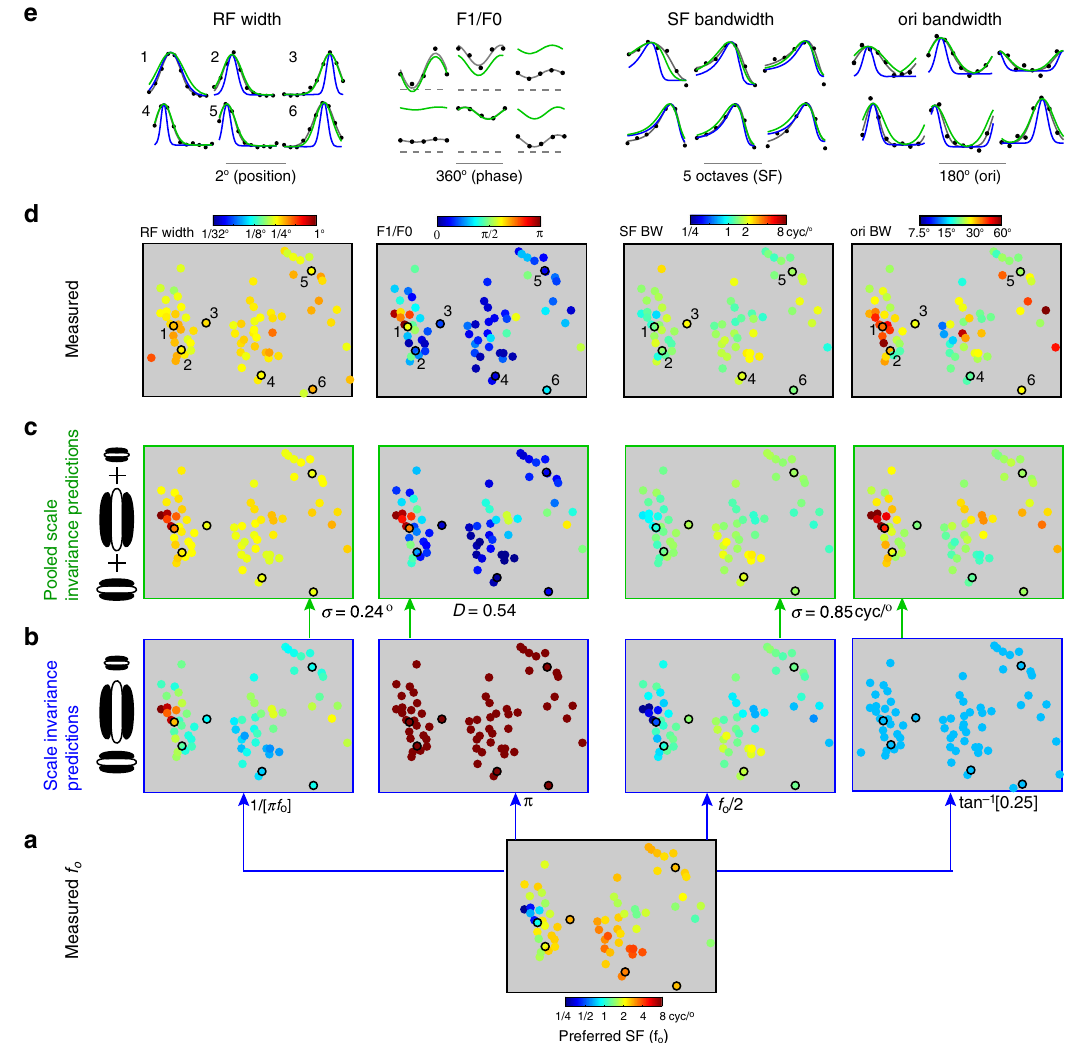
Fig. 7 Summary of pooled scale invariance model and its performance relative to scale invariance. Each of the four columns in b through e corresponds to a different tuning parameter that is predicted by scale invariant pooling, labeled on top. All functional maps shown in this fi gure are from the same ROI. Data yield is the same across maps, with the exception of the measured RF width at top left, which is due to it being measured with a different visual stimulus and inclusion criterion. a Bottom row shows the measured map of f o , which is the independent variable in the models of scale invariance and pooled scale invariance. b First layer of the scale invariant pooling model consists of scale invariant simple cells. Below each map is the formula de fi ning the given parameter. From left to right the maps are of RF width (1 σ ), F 1/ F 0, SF bandwidth (1 σ ), and orientation bandwidth (1 σ ). c Output layer of the scale invariant pooling model. Under each map is the relevant parameter value(s) required to make the predicted map shown. d Measured functional maps shown above their respective model predictions. e Measured tuning and model fi ts of six neurons from this ROI. A number is adjacent to each tuning curve that indicates the neuron in the labeled map below in d . Black dots are data, gray line is the direct fi t to the data, blue line is the scale invariance prediction, and green line is the pooled scale invariance prediction. In the case of the F 1/ F 0 tuning curves, the dashed gray line is the